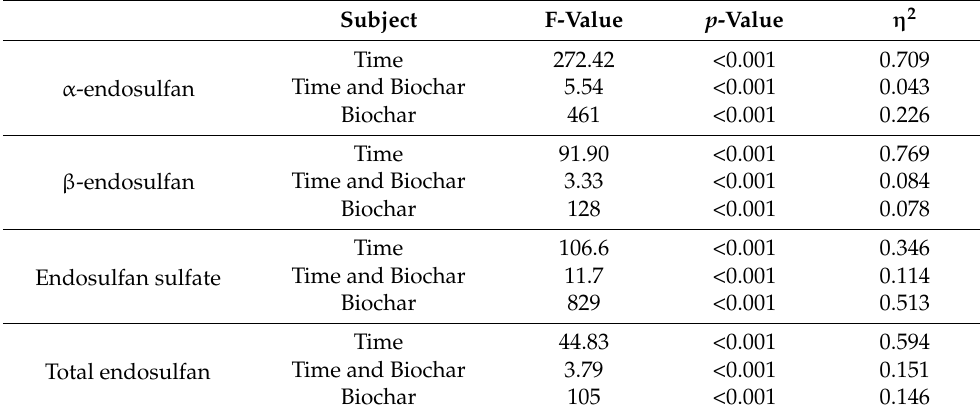
Table 4. Repeated ANOVA, Test of Normality between treatments (endosulfan in